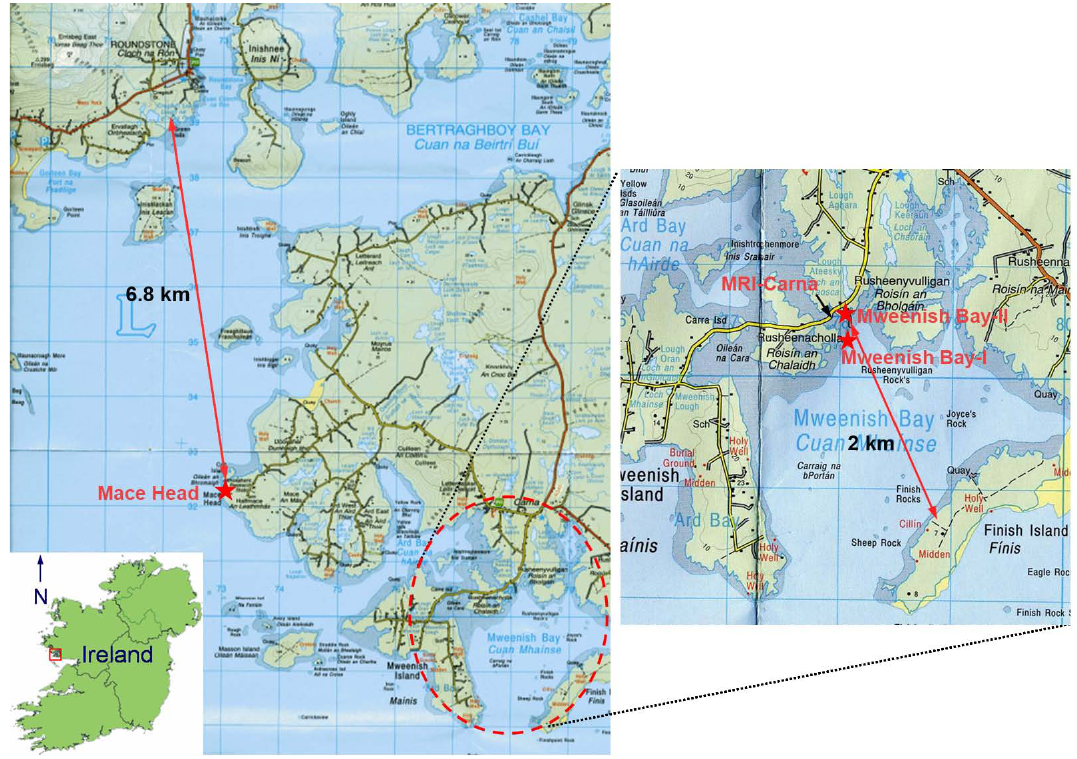
Fig. 1. The denuder sampling sites ( M ) and the light paths of the LP-DOAS measurements at Mace Head and Mweenish Bay, Ireland. distance between Mweenish Bay-I and Mweenish Bay-II is about 100–150